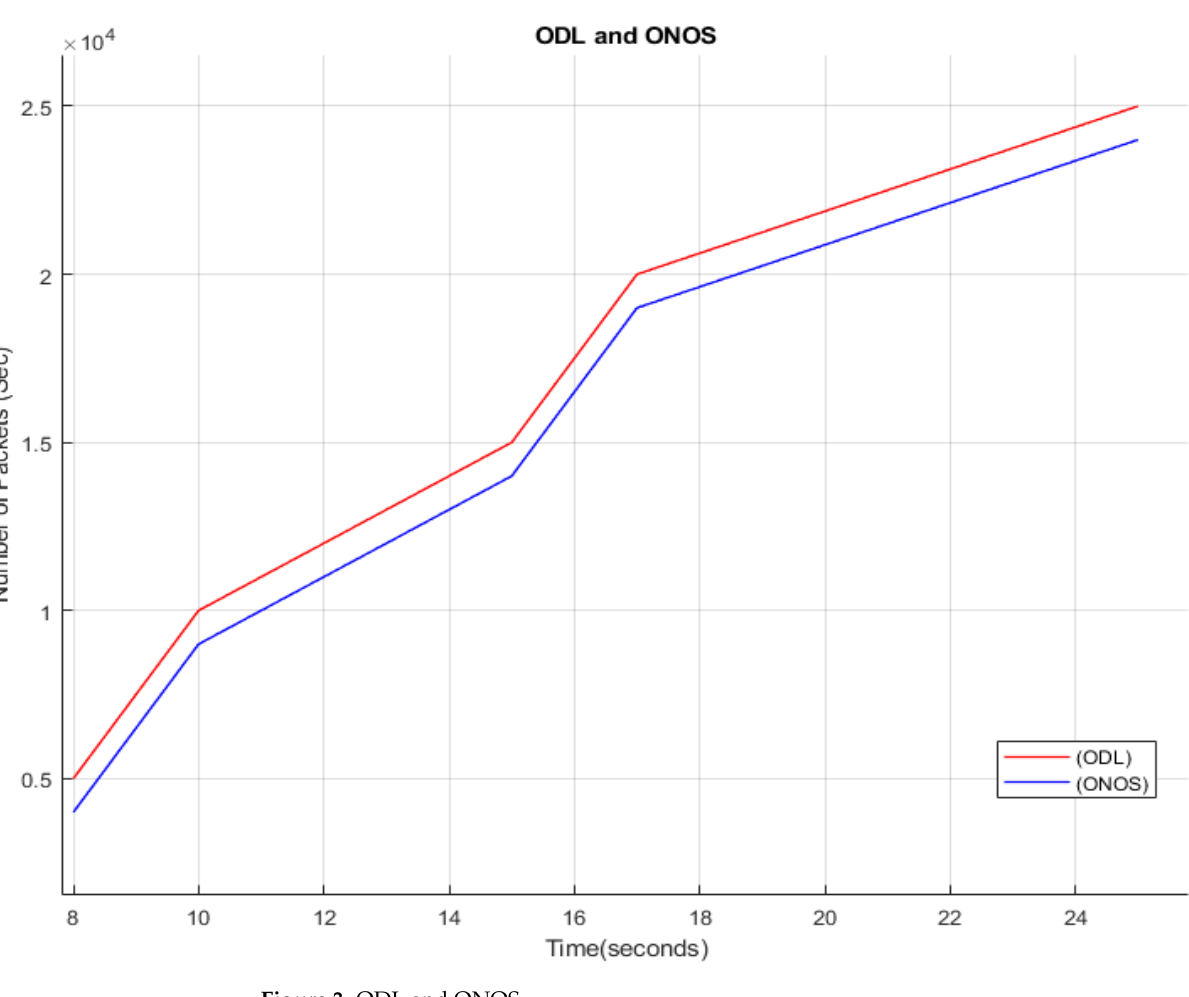
Figure 3. ODL and ONOS.